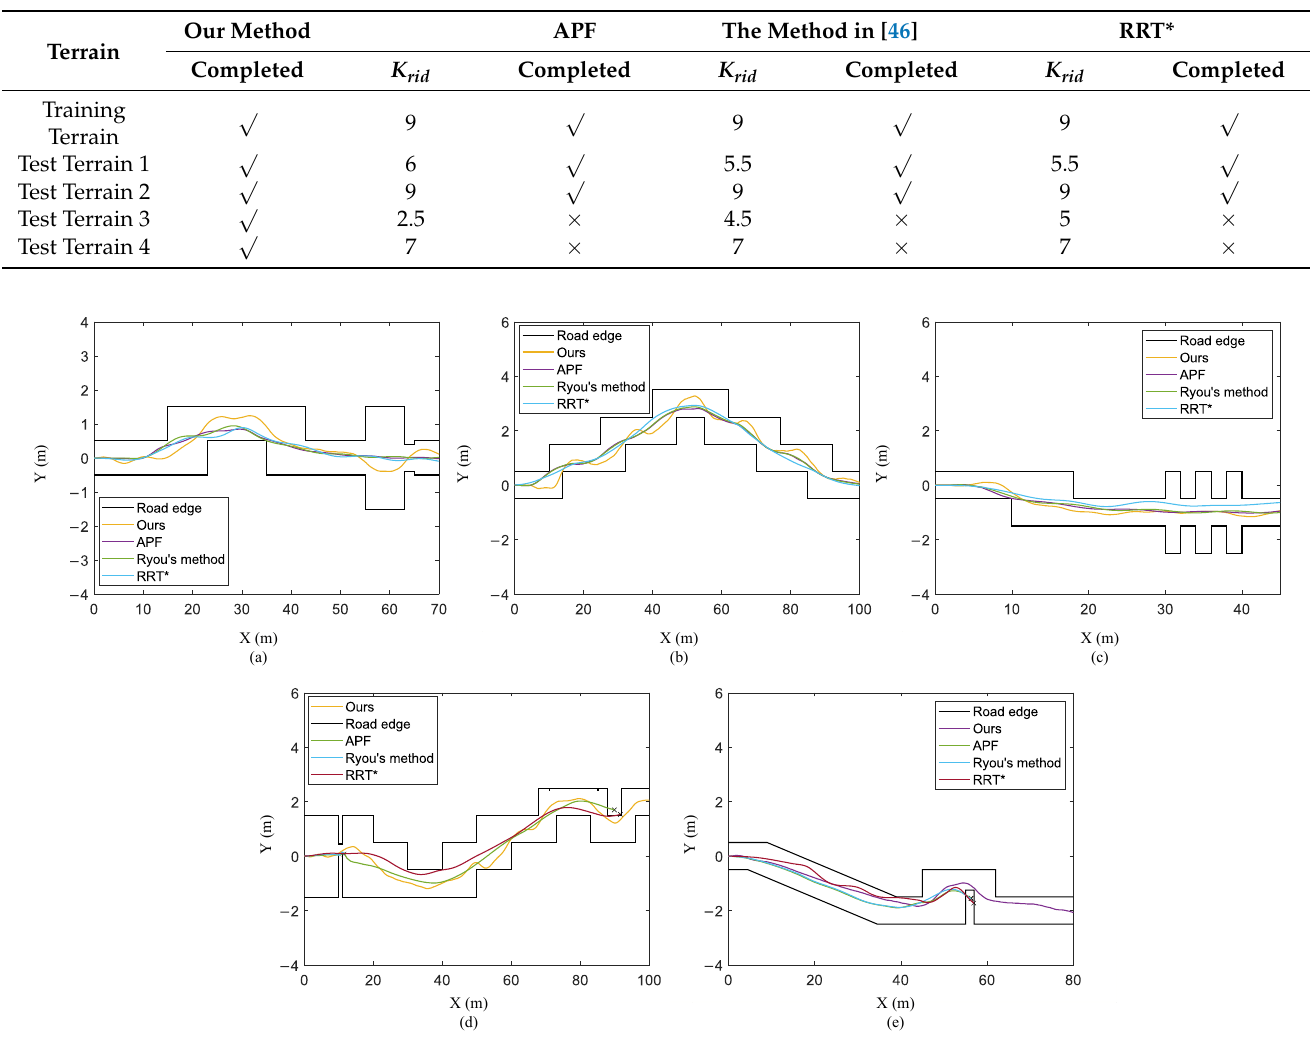
Figure 15. Trajectories using traditional method: ( a ) training terrain; ( b ) test terrain 1; ( c ) test terrain 2; ( d ) test terrain 3; ( e ) test terrain 4.